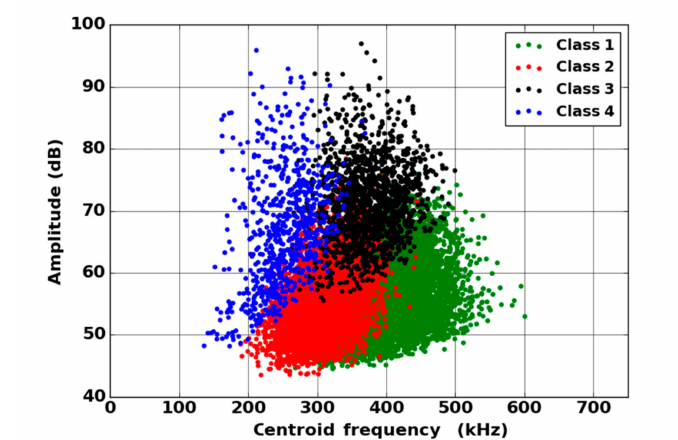
Figure 16. Result of the segmentation, in the plane Amplitude / Centroid Frequency, for the fused AE data recorded during a tensile test on oxide / oxide